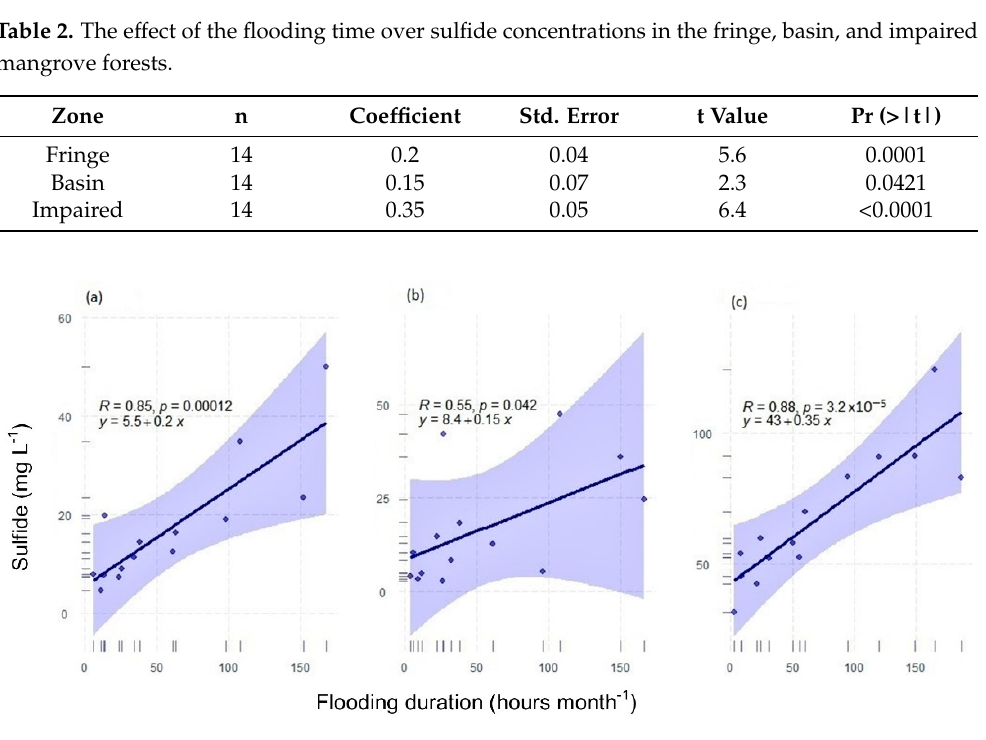
Table 2. The effect of the flooding time over sulfide concentrations in the fringe, basin, and impaired mangrove forests.